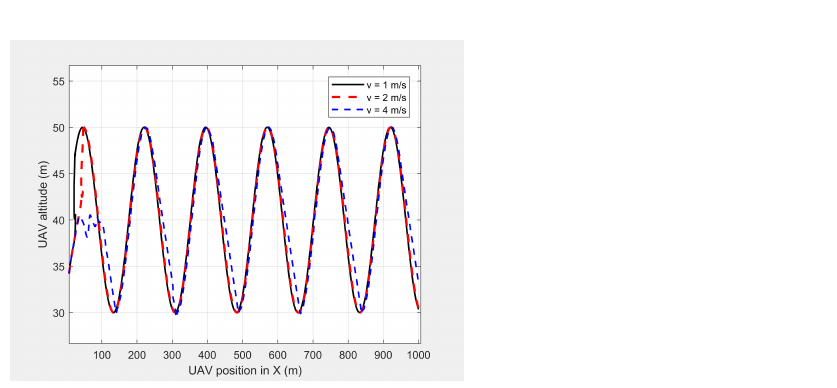
Figure 11. The UAV’s planned path in 2D when following the MGV while moving at different constant velocities.